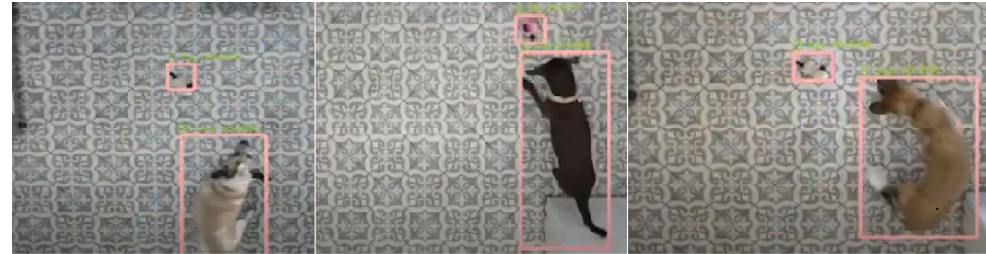
Figure 5. Frames example of dogs and robots being tracked by